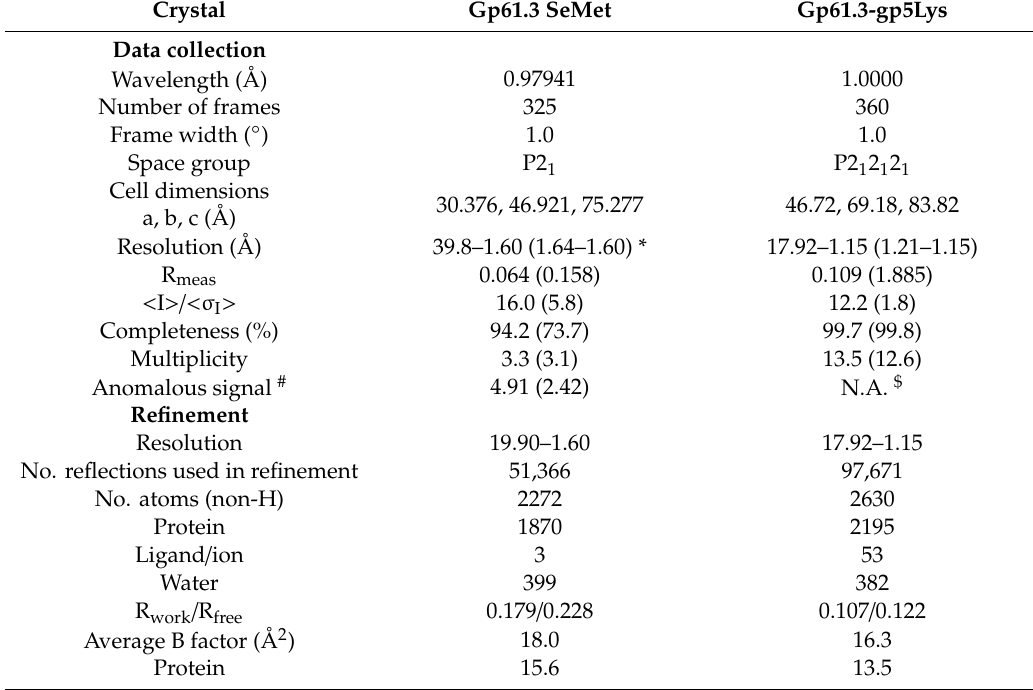
Table 1. X-ray data collection, reduction, and refinement statistics for gp61.3 and gp61.3-gp5Lys complex